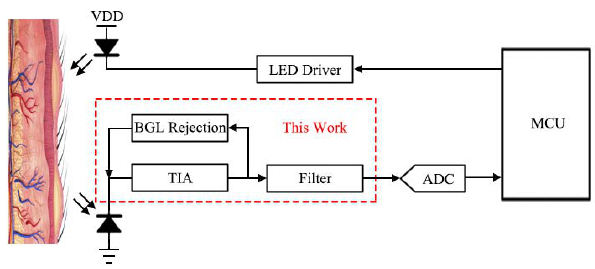
Figure 1. The system diagram of a typical PPG monitoring Figure 1 . The system diagram of a typical PPG monitoring application.